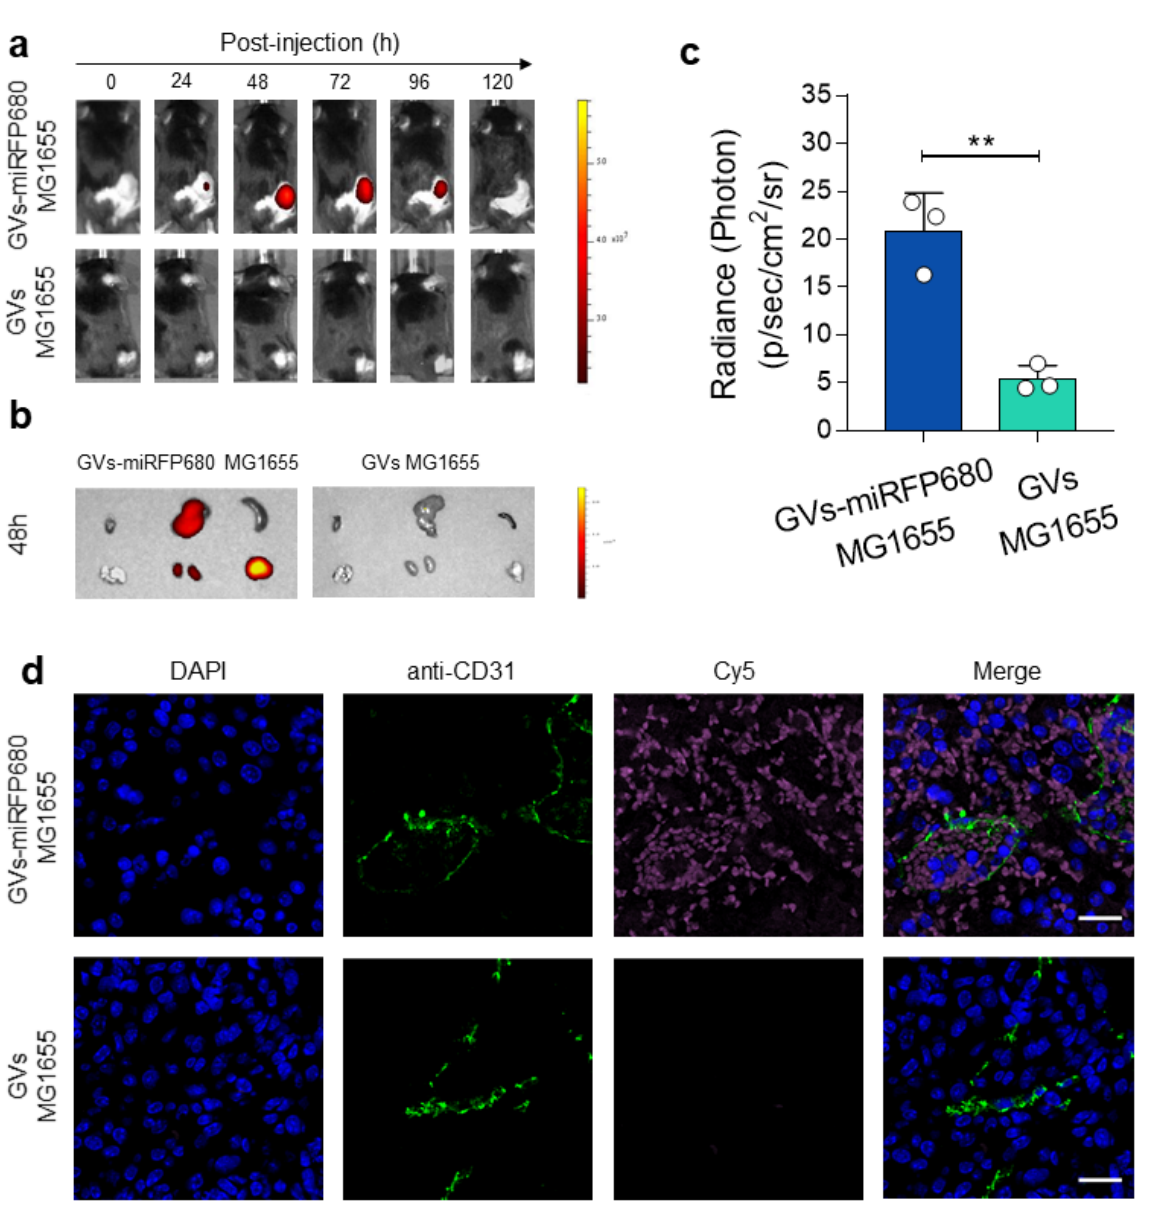
Figure 6. In vivo tracking capability of the tumor-homing characteristic of GVs-miRFP680 MG1655. ( a ) In vivo NIR fluorescent imaging of the tumor-bearing mice was taken at different times after intravenous injection of GVs-miRFP680 MG1655 or GVs MG1655(control). ex = 640 nm, em = 680 nm. ( b ) Ex vivo fluorescence imaging of organs and tumors taken from the tumor-bearing mice at 48 h post-injection. ( c ) Quantitative analysis for the fluorescence accumulated in the tumor in ( b ). ** p < 0.01 vs. control. ( d ) Confocal images of the tumor slices collected from the mice at 48 h post-injection of GVs-miRFP680 MG1655 or GVs MG1655 (control). The green and pink signals derived from the fluorescence of anti-CD31-stained blood vessels and the engineered GVs-miRFP680 MG1655 bacteria, respectively. Scale bars represent 20 µm.